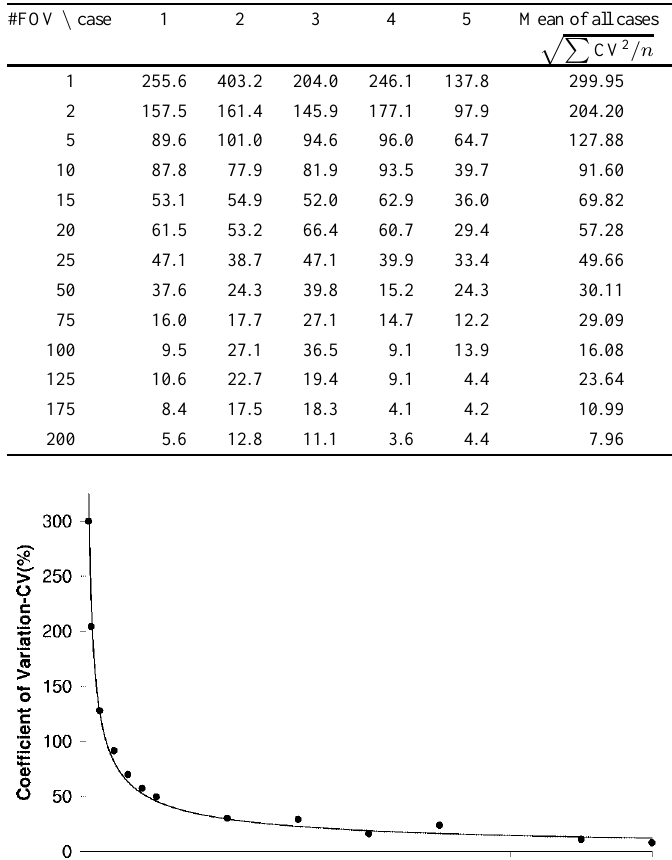
CV (%) of assessments of fractional volume of S100 positive cells as a function of the number of fields of vision (#FOV) assessed in a computer simulated systematic